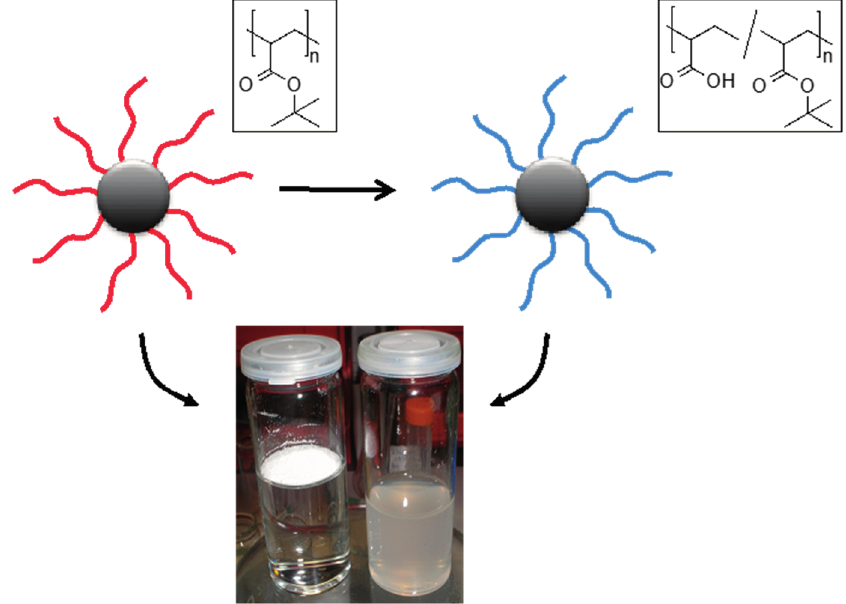
Figure 5. Hydrophobic PBMA decorated Si-NPs floating on water (left) and hydrophilic PMAA Si-NP suspended in